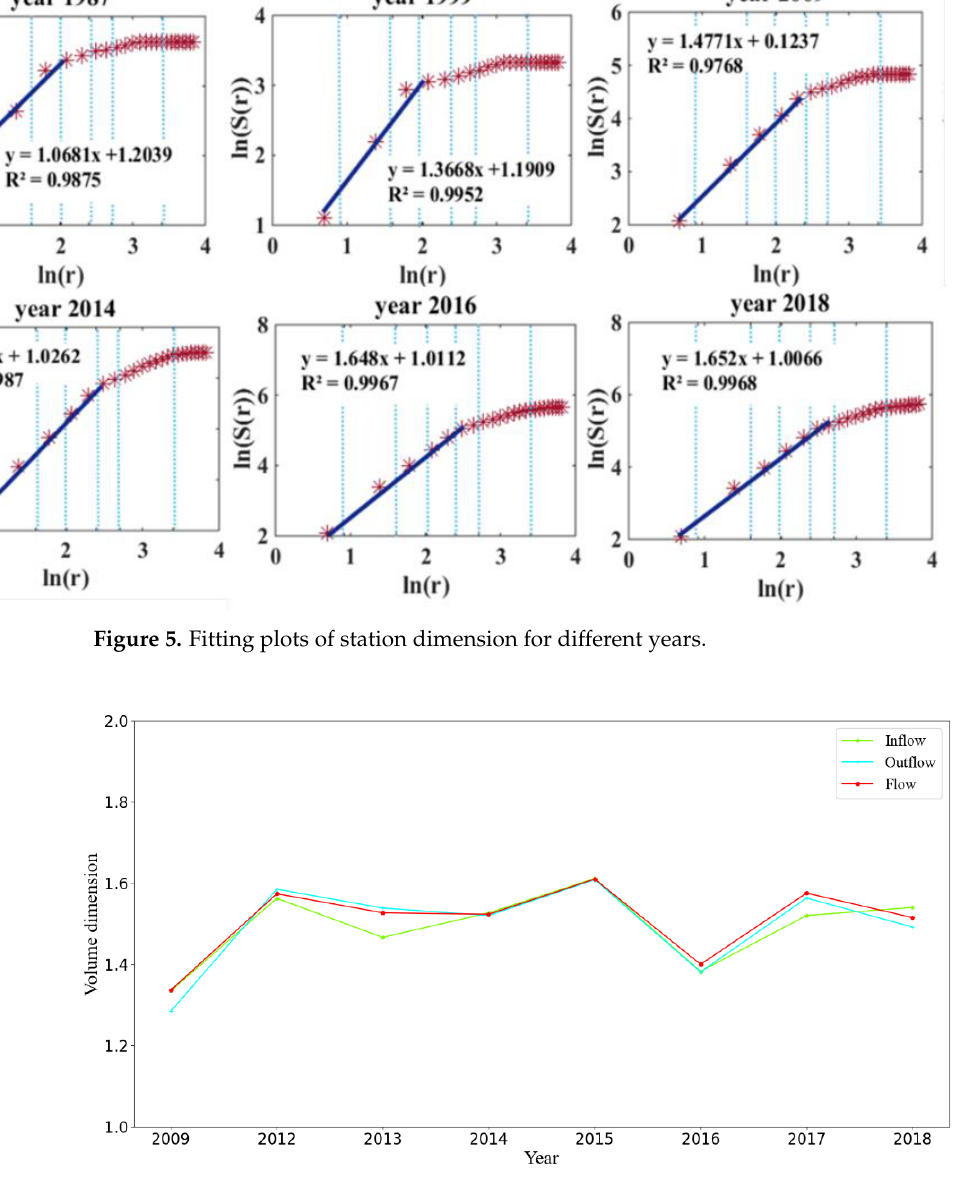
Figure 6. Volume dimension for each year.